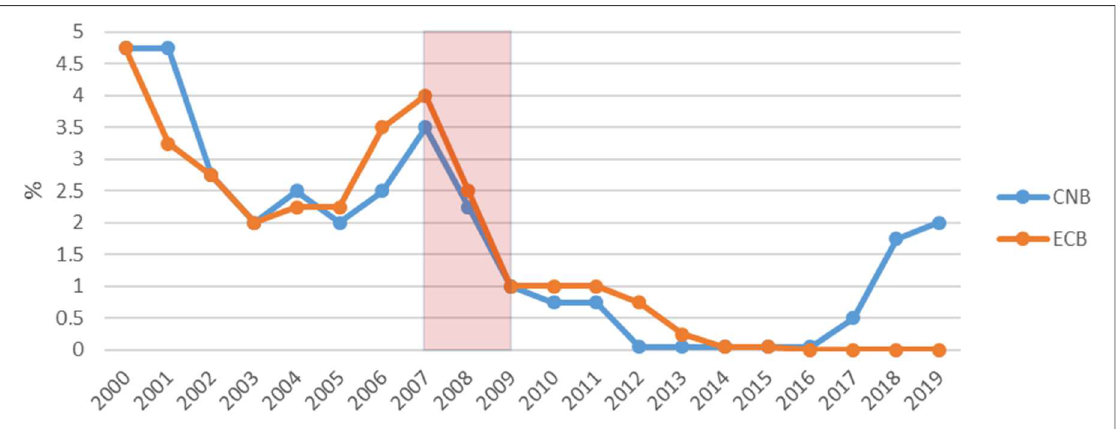
Figure 1. The interest rate (31 December) on the main refinancing operations in the Eurozone (ECB) and in the Czech Republic (CNB) (Source: The European Central Bank and the Czech National Bank).